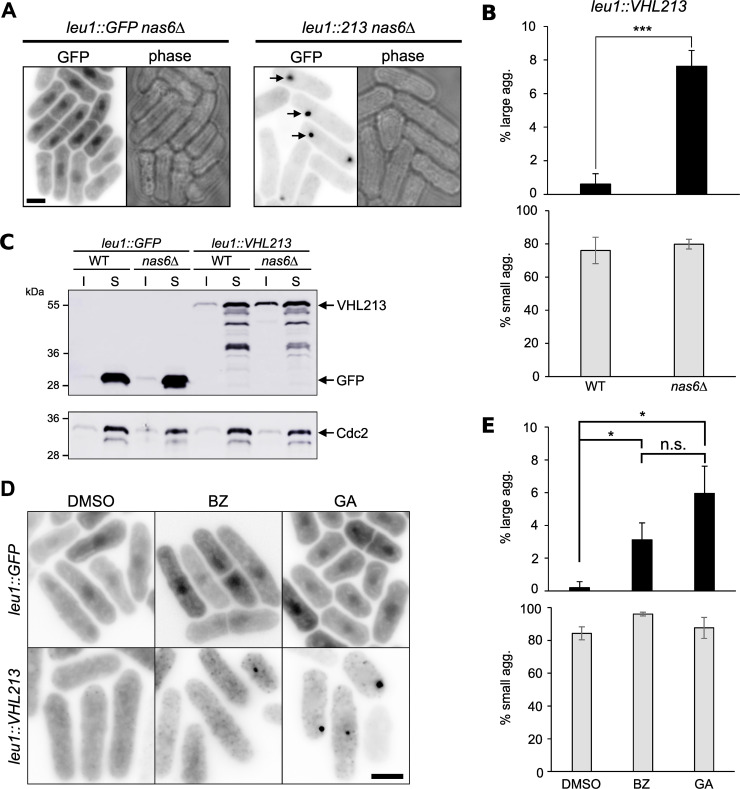
Inhibition of the proteasome or of the Hsp90 chaperone stimulates GFP-pVHL213 aggregation.A) Reversed fluorescent (left) or phase contrast (right) images of leu1::GFP nas6Δ and leu1::VHL213 nas6Δ cells. Arrows depict large GFP-pVHL213 aggregates. B) Percentage of large (upper panel) and small (lower panel) aggregate-containing cells in leu1::VHL213 (WT) and leu1::VHL213 nas6Δ (nas6Δ) cells (mean±s.d. from three independent experiments; ***, p<0.001, Student t test). C) Western blot analysis of GFP or GFP-pVHL213 expression in leu1::GFP (WT and nas6Δ) and leu1::VHL213 (WT and nas6Δ) backgrounds: Soluble (S) and Insoluble (I) fractions are shown. Cdc2 was used as a loading control. D) Reversed fluorescent images of leu1::GFP and leu1::VHL213 cells cultured in the presence of DMSO (vehicle), Bortezomib (BZ) or Geldanamycin (GA). E) Percentage of large (upper panel) and small (lower panel) aggregate-containing cells in leu1::VHL213 cells treated with DMSO, BZ or GA (mean±s.d. from three independent experiments; n.s., not significant; *, p<0.5, Student t test). Bars: 5 μm.